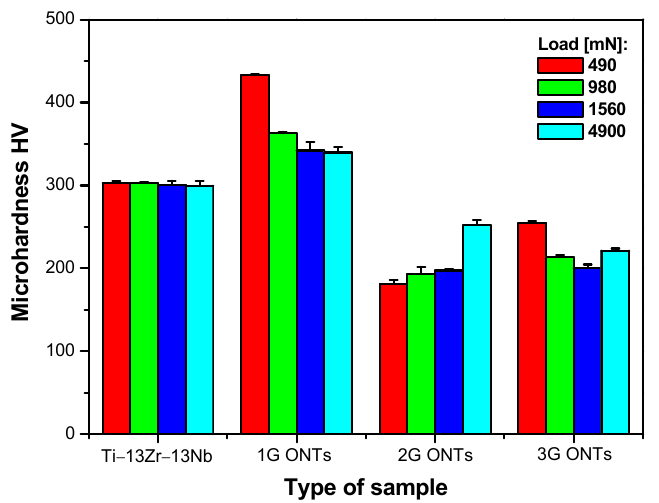
Figure 3. Vickers microhardness of the Ti–13Zr–13Nb alloy surface before and after anodizing with variable loads.